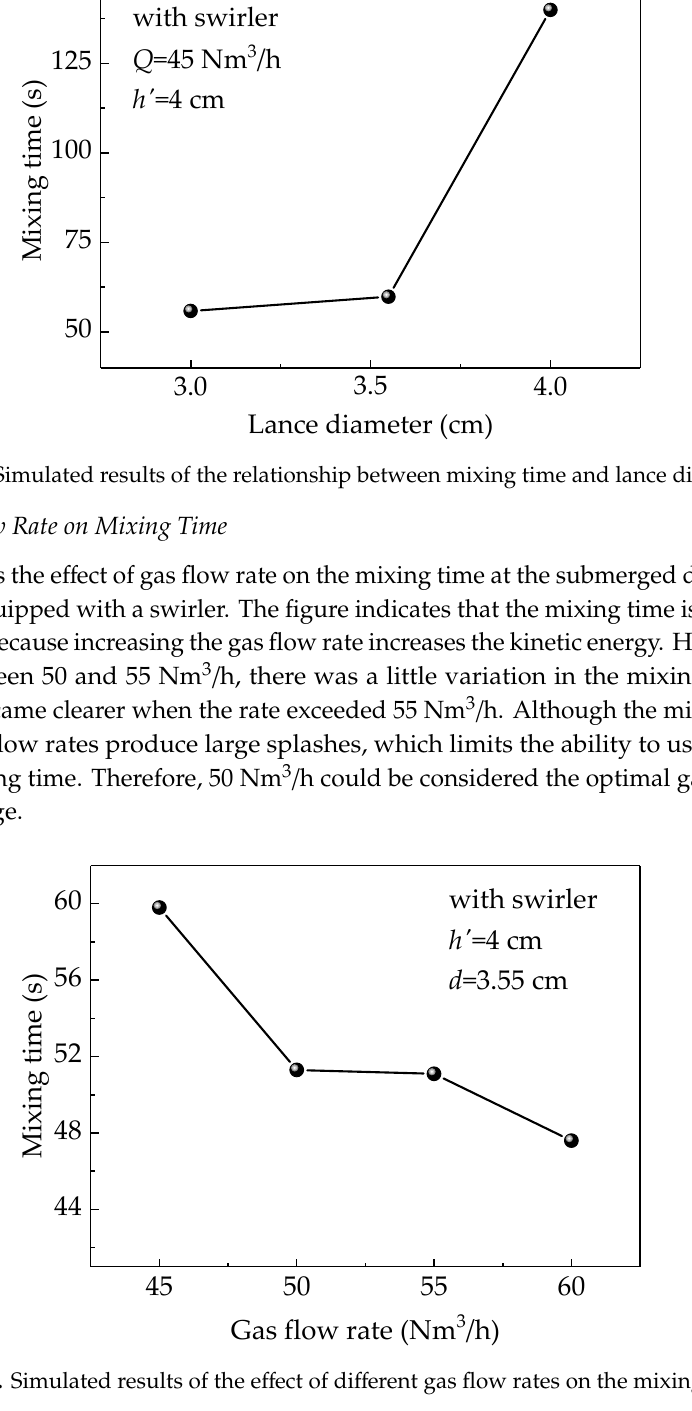
( b ) Figure 8. Simulated results of mean turbulent viscosity distributions. ( a ) With a swirler and ( b ) without a swirler. 3.3. Effect of the Lance Diameter on Mixing Time